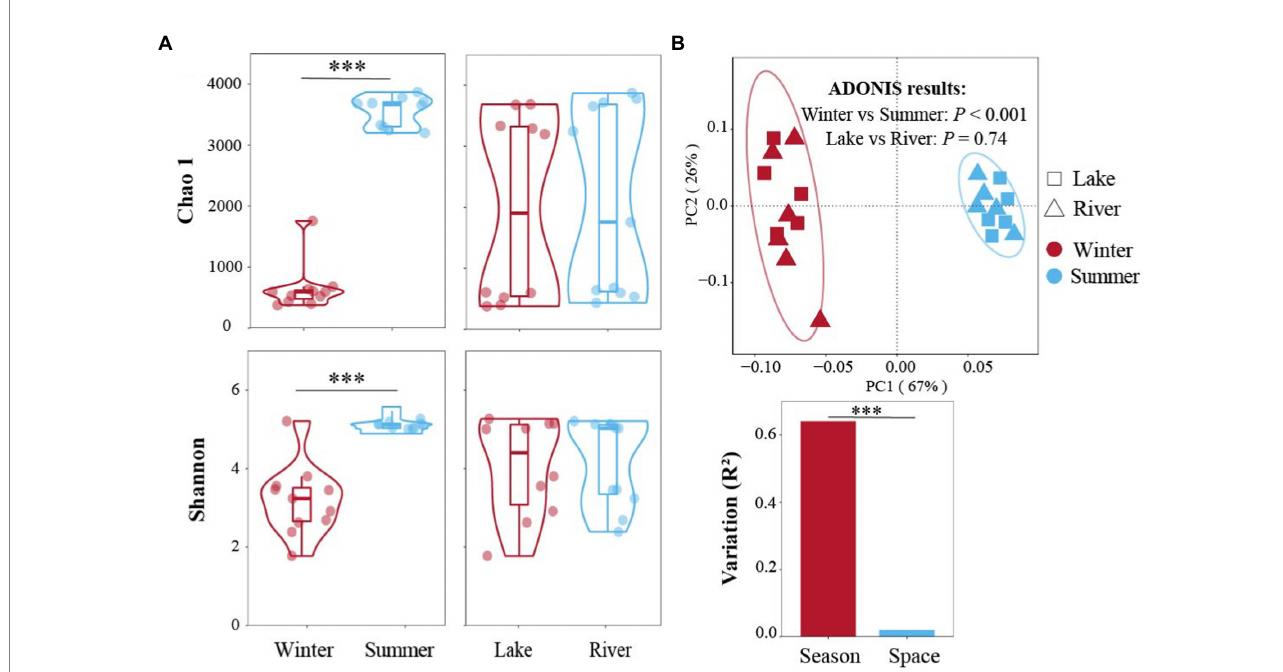
FIGURE 2 Bacterial community diversity in winter and summer across subsidence lake and natural river. (A) The difference of Chao 1 and Shannon α -diversity index between different seasons and sites. (B) Bray Curtis distances-based PCoA of bacterial community structures among different spatial and temporal scales using adonis analysis. Two comparisons with Wilcoxon tests, * p < 0.05, ** p < 0.01, *** p <